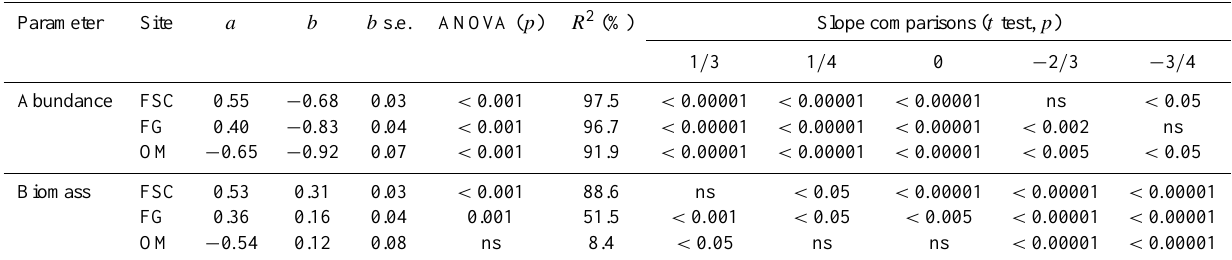
Table 4. Summary of regression analyses for abundance and biomass relationships with nominal body weight for three study sites (FG, Fladen Ground; FSC, Faroe–Shetland Channel; OM, Oman Margin) assuming a relationship parameter = aW b . ANOVA probability ( p ), coefficient of determination ( R 2 ), prefactor ( a ), scaling ( b ), standard error for b and its t -test comparison probabilities ( p ) with standard allometric ratios are